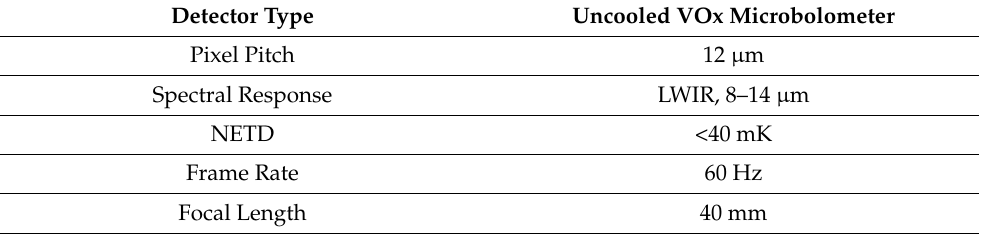
Table 1. The basic parameters of the IR